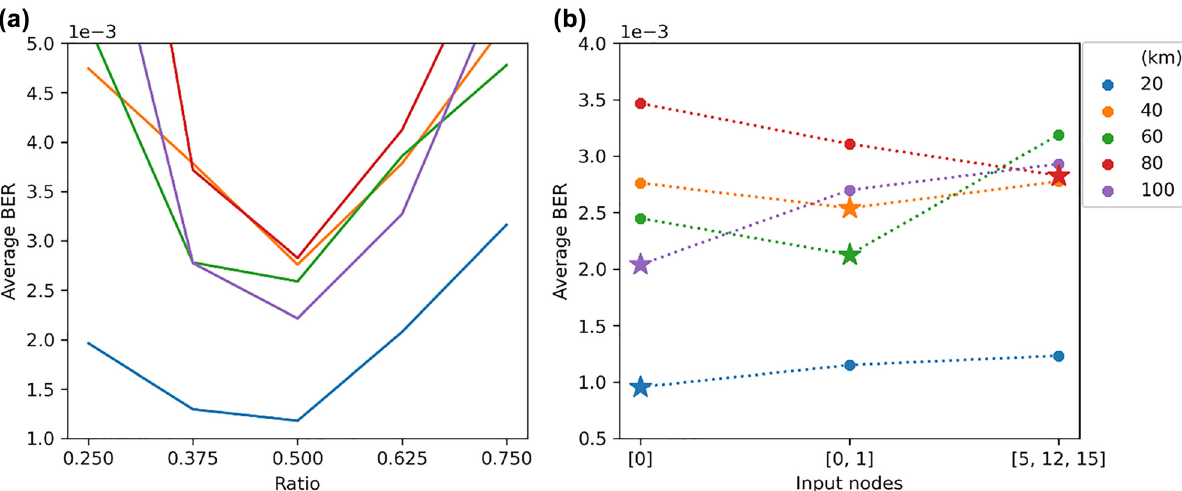
Figure 6: Optimization of reservoir parameters using BER metric for all link lengths individually, two parameters are studied: (a) (Left) the interconnection delay expressed as a ratio of the delay induced in seconds to the symbol rate of the signal. (b) (Right) the nodes used to inject the signal into the